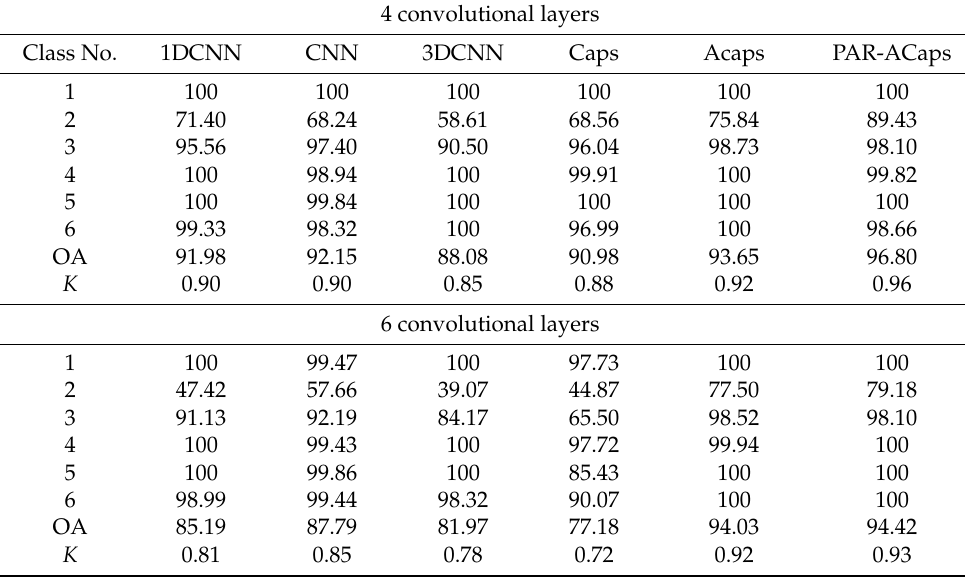
Table 7. The overall accuracy (%), per-class accuracy (%), and the Kappa coefficients ( K ) of SA dataset derived from CNN, Caps, ACaps, and PAR-ACaps with relatively deeper architectures. 4 convolutional layers Class